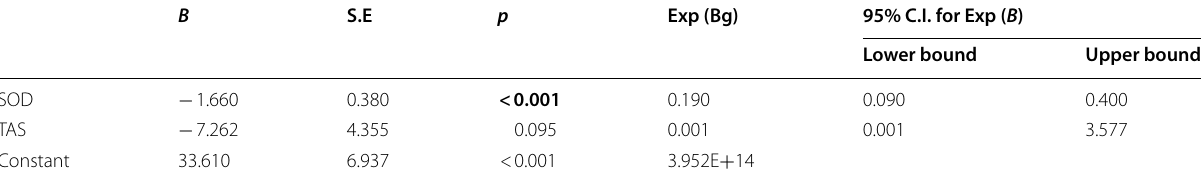
Bold indicates p -value Binary Logistic